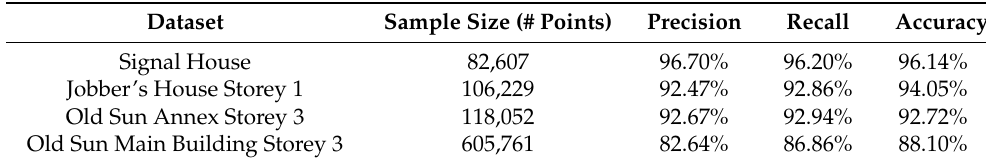
Table 4. 2D floor plan and 3D model creation results.